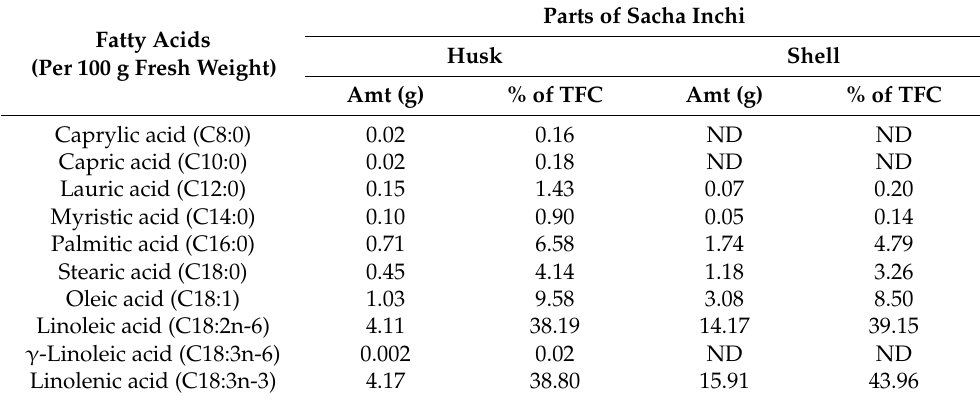
Table 3. Fatty acid profile in the husk and shell of sacha